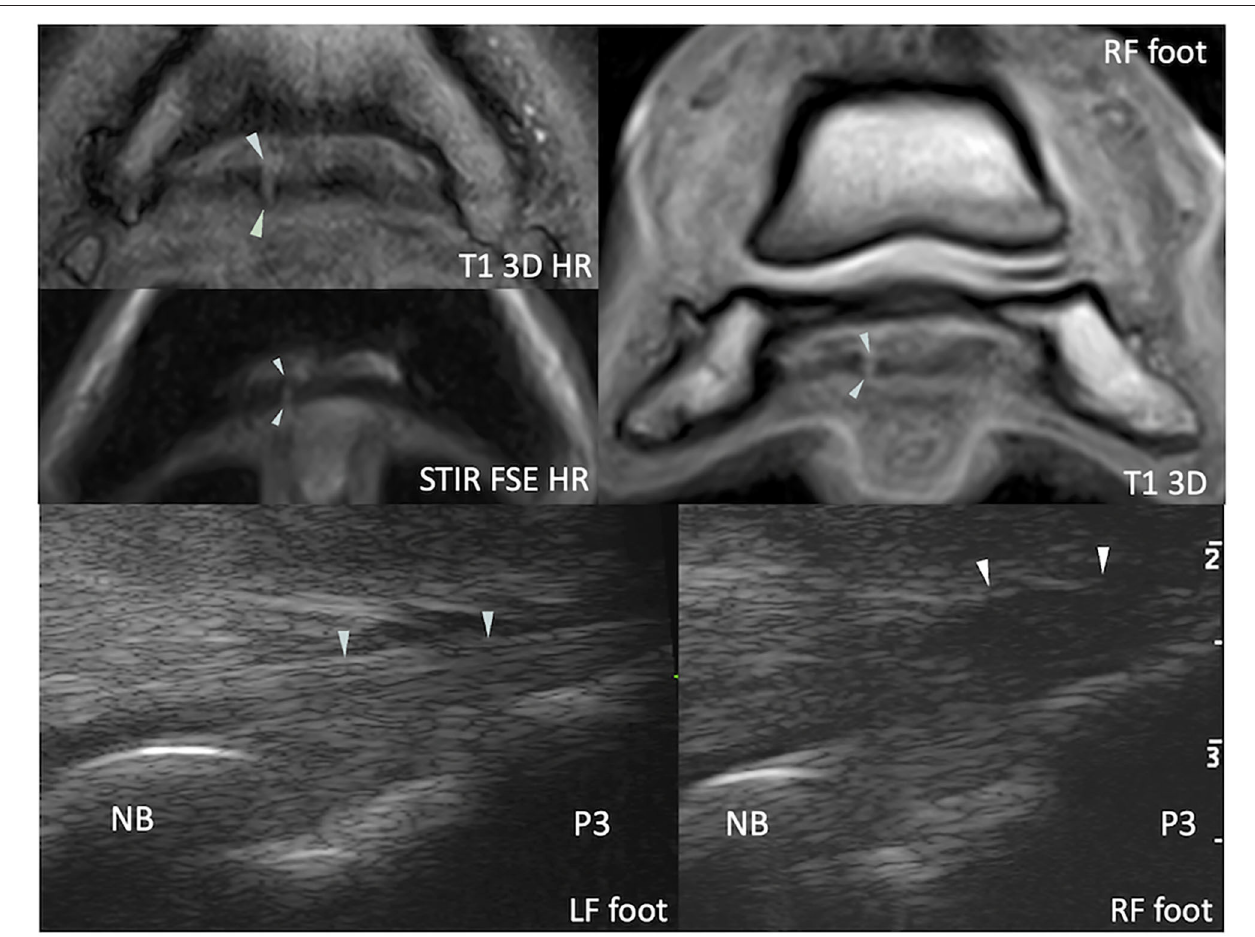
FIGURE 3 | Transverse magnetic resonance (MR) images of the right front foot (top) and comparative transcuneal longitudinal ultrasonographic images of the left and right front feet (bottom) at the infrasesamoidean level. A hyperintense parasagittal tendon split is visible in the medial lobe of the deep digital flexor tendon on MR images (arrowheads). At ultrasound, the abnormal tendon (right front foot) appears thickened in its most distal portion and has a slightly convex palmar border (arrowheads). The tendon also appears hypoechoic in comparison to the contralateral foot, although this may be due to anisotropy and induced by a non-parallel fiber alignment to the ultrasound probe. T1 3D (HR), (high resolution) tridimensional gradient echo T1 weighted image; STIR FSE HR, high resolution fast spin echo short tau inversion recovery weighted sequence; NB, navicular bone; P3, distal phalanx.